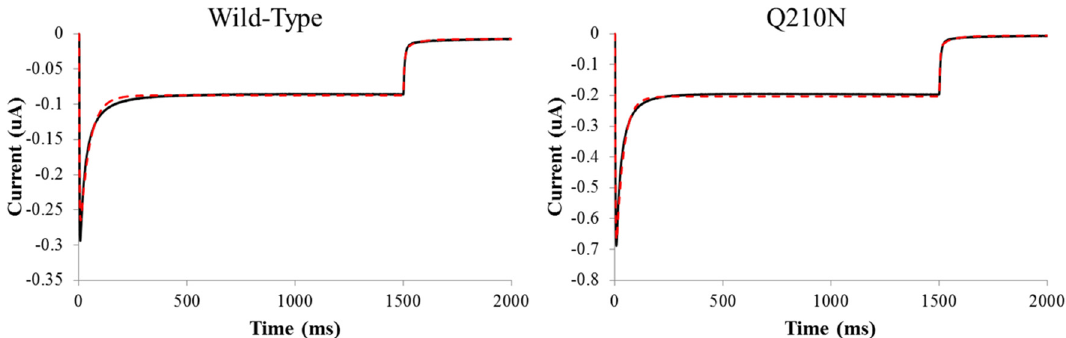
Figure 6. Four-state photocycle theoretical fits. Theoretical fits were obtained by parameter optimization and objective function minimization as described in the Materials and Methods. Solid black line is the experimental average while the dashed red line is the average theoretical fit.